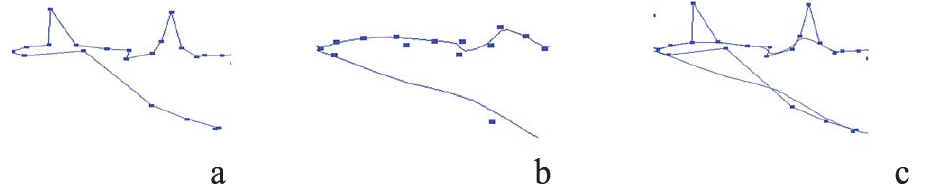
Fig. 4. Motion tracking chart with impulsive noise and curve fitting with reprocessing. (a) Motion tracking chart with impulsive noise. (b) Trajectory chart after curve fitting based on preprocessing. (c) Motion tracking chart with impulsive noise and the curve fitting chart obtained by